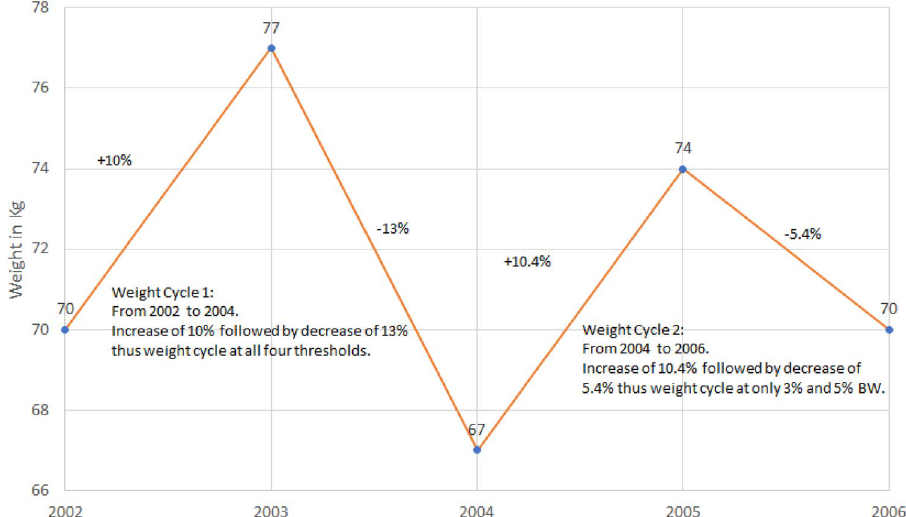
Figure 3. Example of body weight cycling for a participant with 5 measurements with 2 cycles at 3% and 5% thresholds, and 1 cycle at 7% and 10% thresholds. The BW cycle was defined by identifying